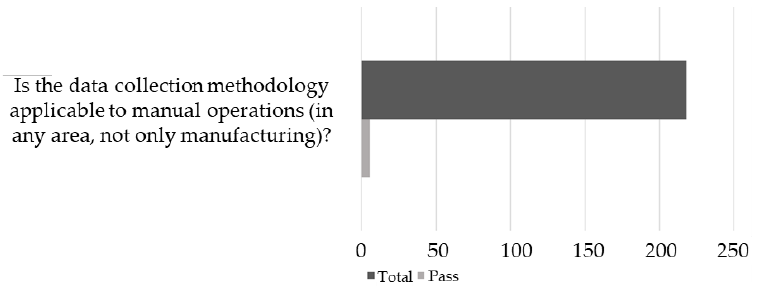
Figure 12. Quality check of complying journal articles and conference papers for Domain 2.